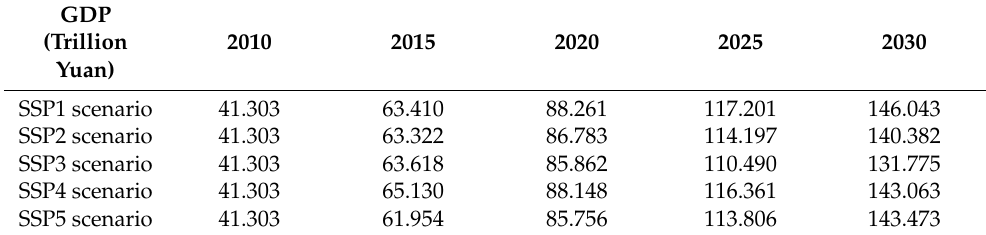
Table A2. The simulation results of the Chinese GDP SSPs data.